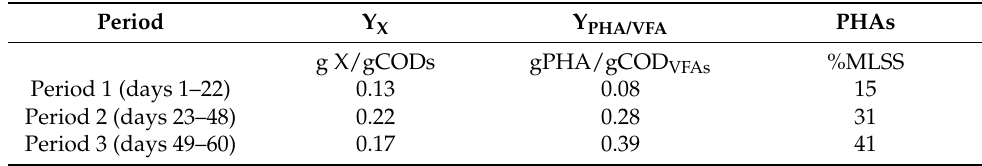
Table 4. Yields of X, PHAs, and %PHA based on